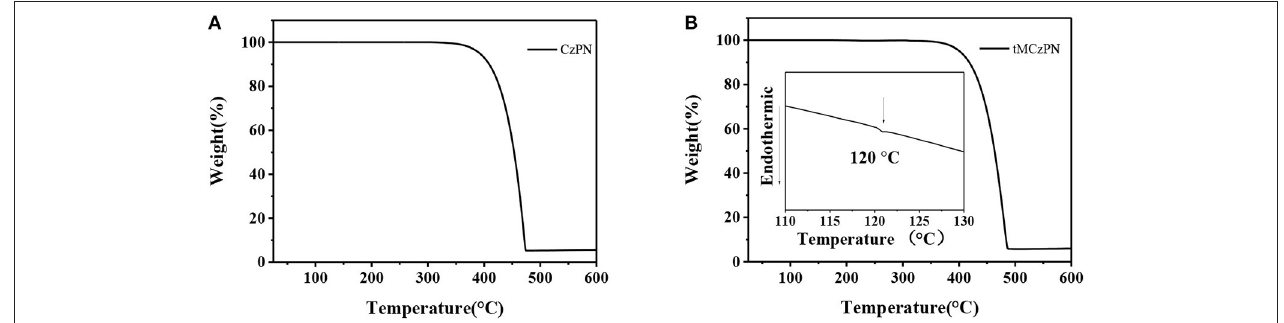
FIGURE 4 | UV-Vis absorption spectra in toluene, fluorescence spectrum in DPEPO film at room temperature, and phosphorescence spectra in DPEPO film at 77K of (A) CzPN and (B) tMCzPN. Fluorescence spectra of (C) CzPN and (D) tMCzPN in different solvent (Tol, toluene; DCM, dichloromethane; and THF, tetrahydrofuran). (E) Temperature-dependent transient PL decay spectra of tMCzPN doped in DPEPO film by exciting at 300 nm (20 wt.%).